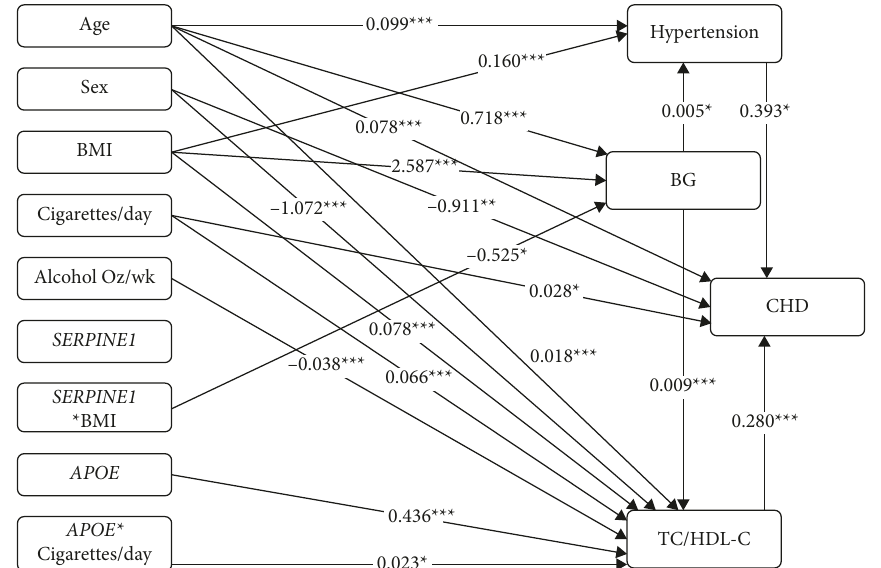
Figure 6: Path estimates of SEM of gene-by-environment interaction in the development of CHD from annals of human genetics by Mi et al.